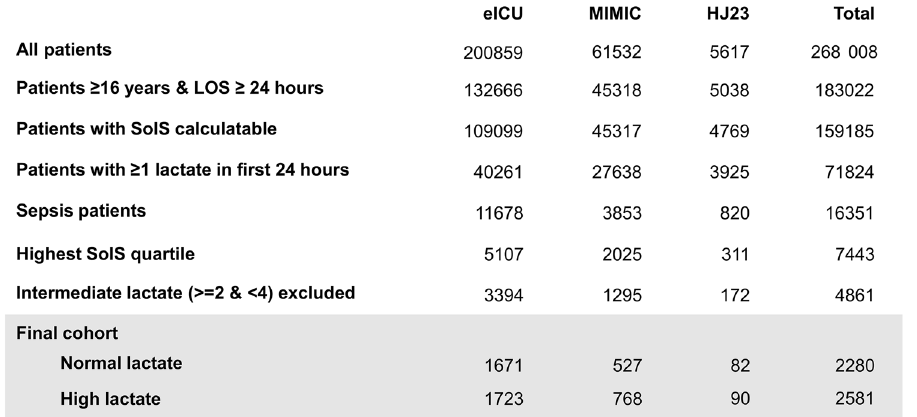
Figure 1. Overview of cohort building and patient numbers by dataset. A total of 16,351 septic patients fulfilling the inclusion criteria were identified. Restricting to highest SoIS quartile and exclusion of intermediate lactate values resulted in a final cohort of 4861 patients. SoIS Severity of Illness Score, LOS length of stay in the